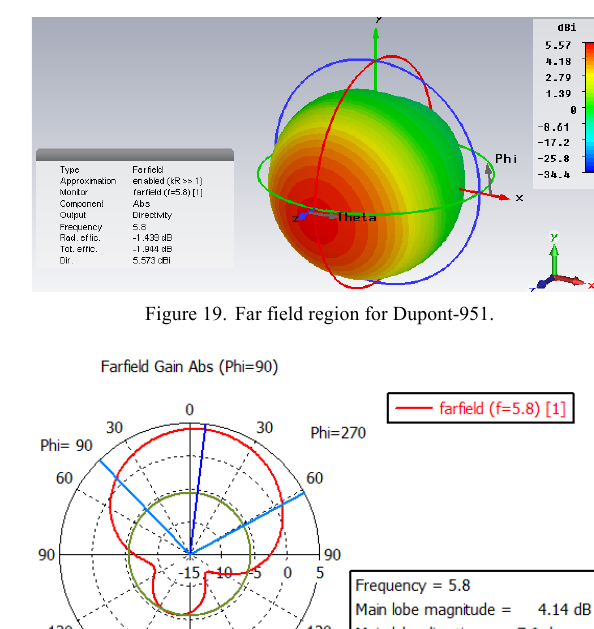
Figure 15. Return loss for Bakelite.